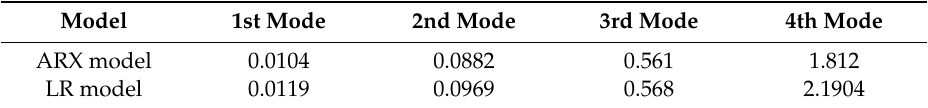
Table 3. Comparison of root mean squared error (RMSE) values between ARX model and linear regressive